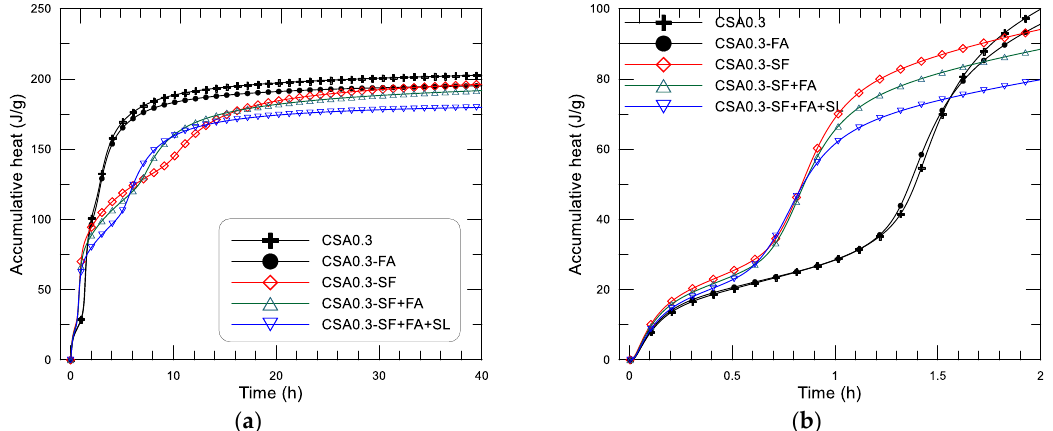
Figure 8. Accumulative heat and age diagram of the CSA paste with different addition of SCMs: ( a ) results within 40 h, ( b ) results within the initial 2 h.